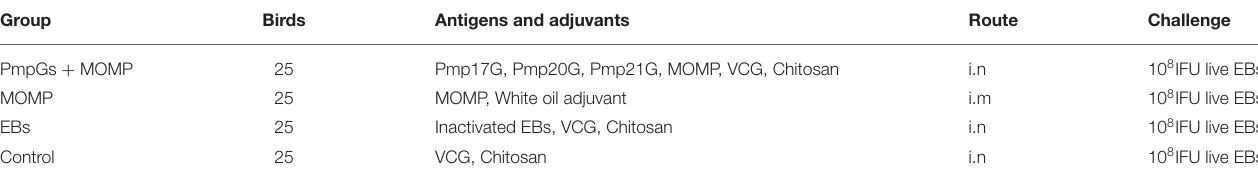
TABLE 2 | Inoculations and challenge of breeder ducks. Group Birds Antigens and